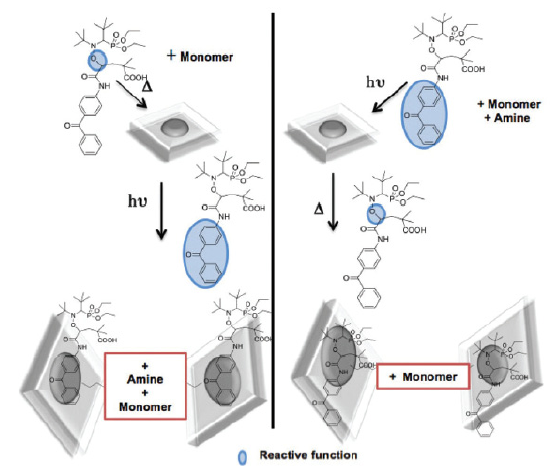
Figure 7. Use of a dual photoinitiator for the linkage of two polymer films by combining UV and thermal polymerization in laminate. Reprinted with the permission of RSC from ref. [56]